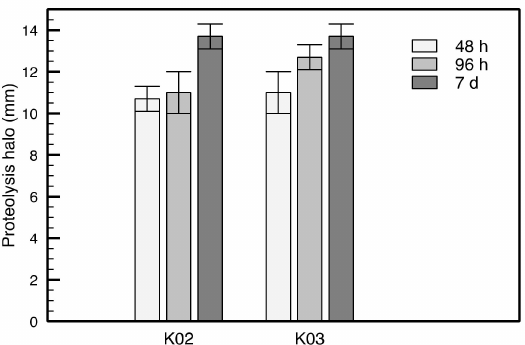
Figure 2. Casein hydrolysis activity of kefir beverages. Hydrolysis of casein was evaluated measuring proteolysis halo on skim milk agar. Caseinase activity was measured in triplicates and error bars represent standard deviation.